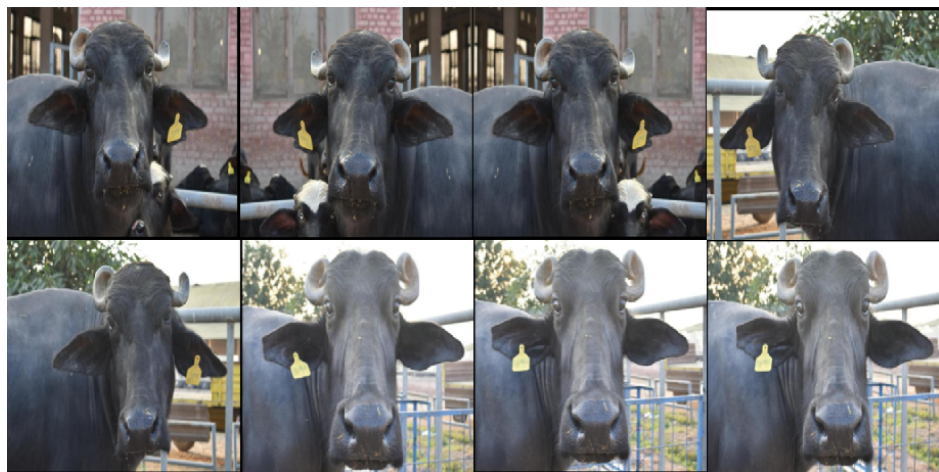
Figure 2. Number of data samples increased for training through